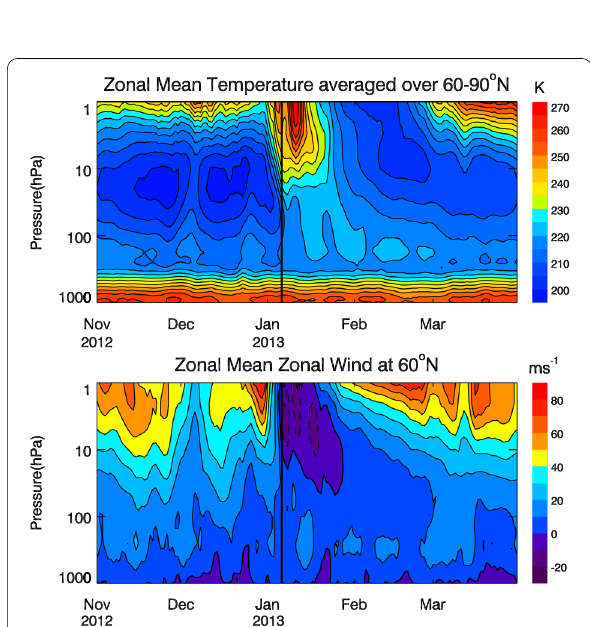
Fig. 5 Altitude-time cross-sections of the zonal-mean temperature averaged from 60 ◦ N to 90 ◦ N (top) and zonal-mean zonal wind at 60 ◦ N (bottom) during the winter of 2012/2013. The thick vertical line denotes 6 January 2013, which is the SSW central